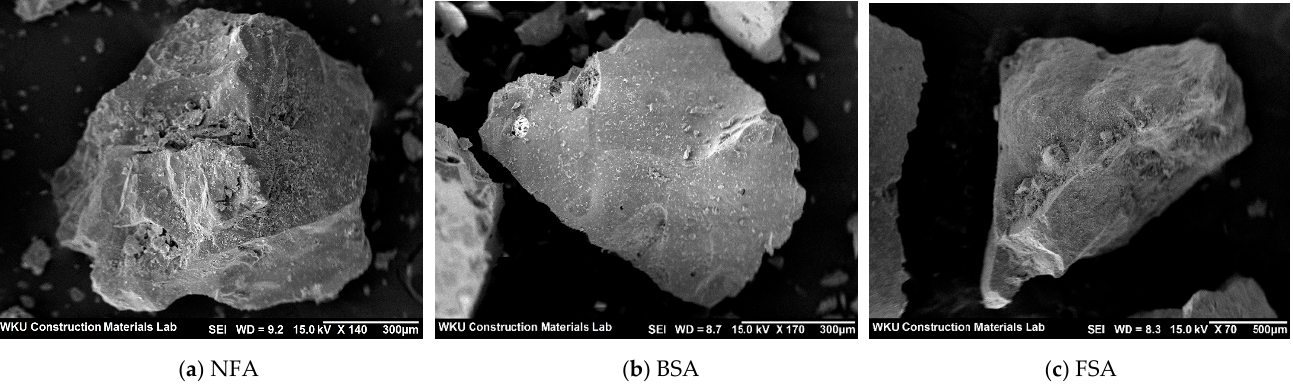
Figure 1. SEM images of NFA, BSA and FSA: ( a ) NFA, ( b ) BSA, ( c ) FSA